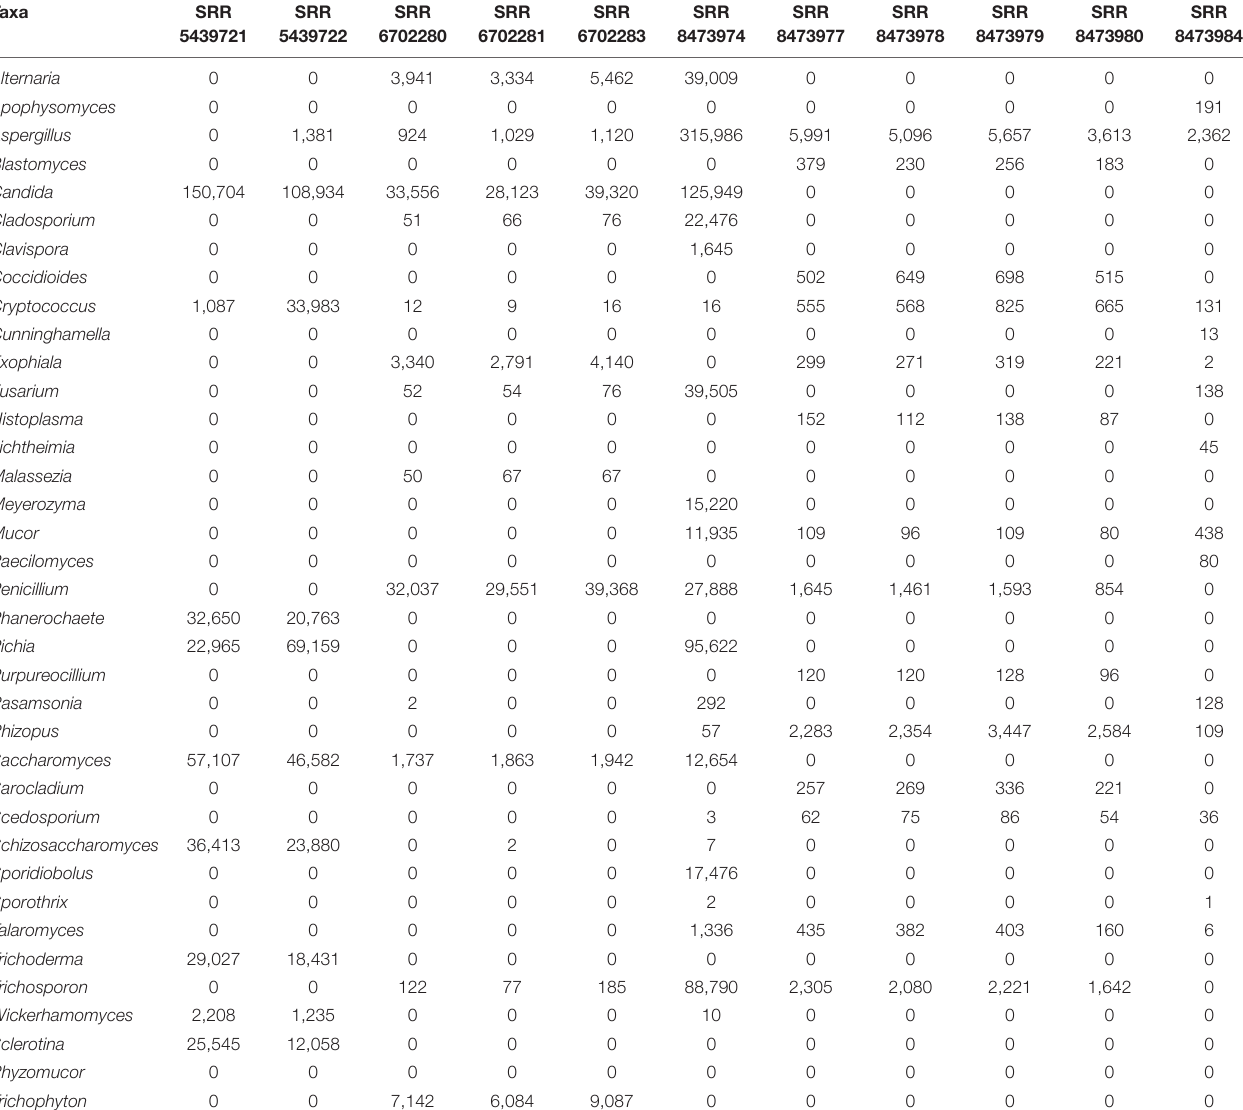
TABLE 1 | Absolute count of reads affiliated of each genus among the different datasets of the mock community (determined by BLASTn against NT database).